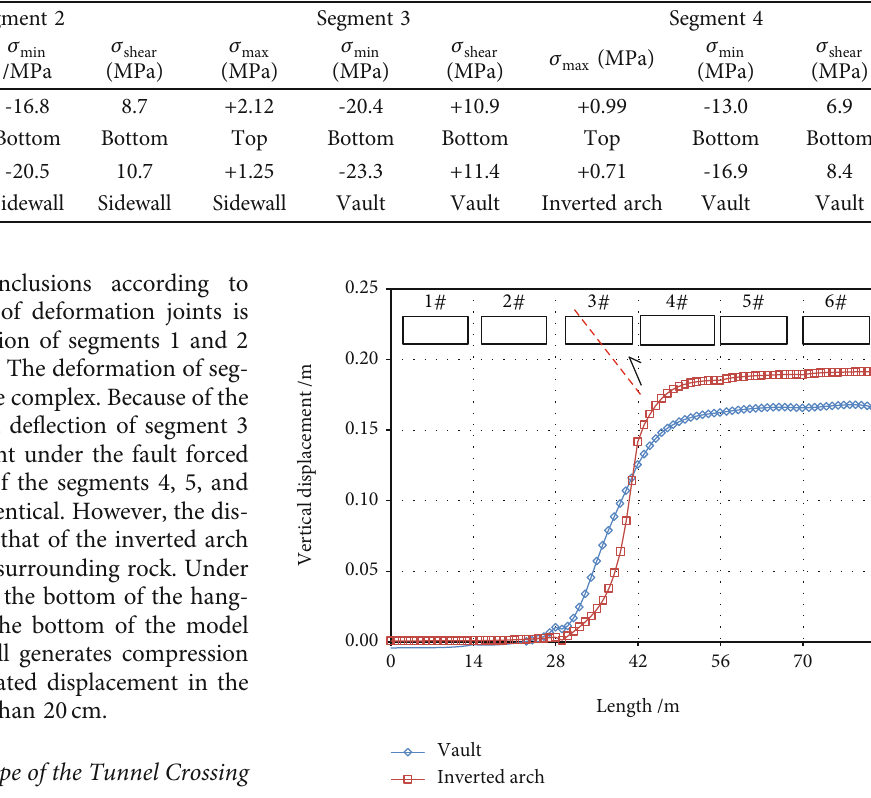
Figure 9: Lining deformation curve of the circular section under fault dislocation.